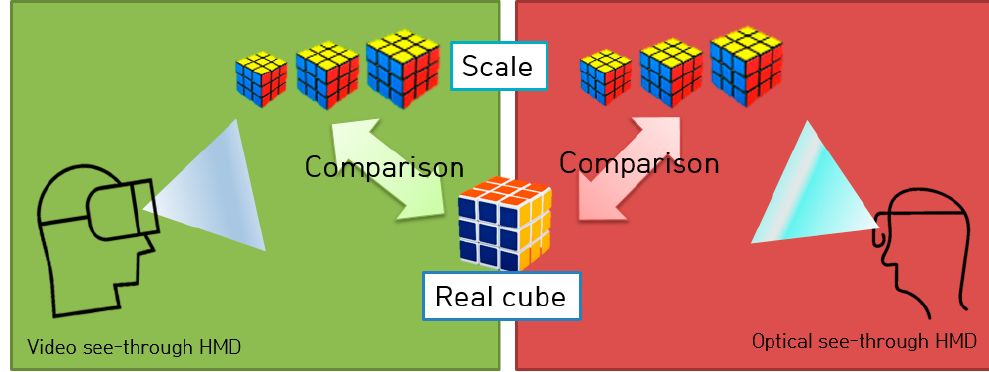
Figure 2. Scale perception in comparing a real cubic puzzle with a virtual one using a video see-through head-mounted display (HMD) and an optical see-through HMD. In the experiment, two cubes (each with a real and a virtual cube) appeared at the same time for comparison.